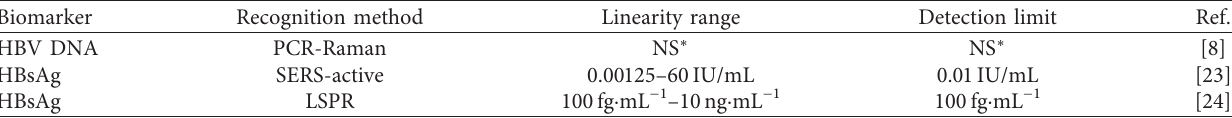
Table 3: Raman spectroscopy detection of HBV.